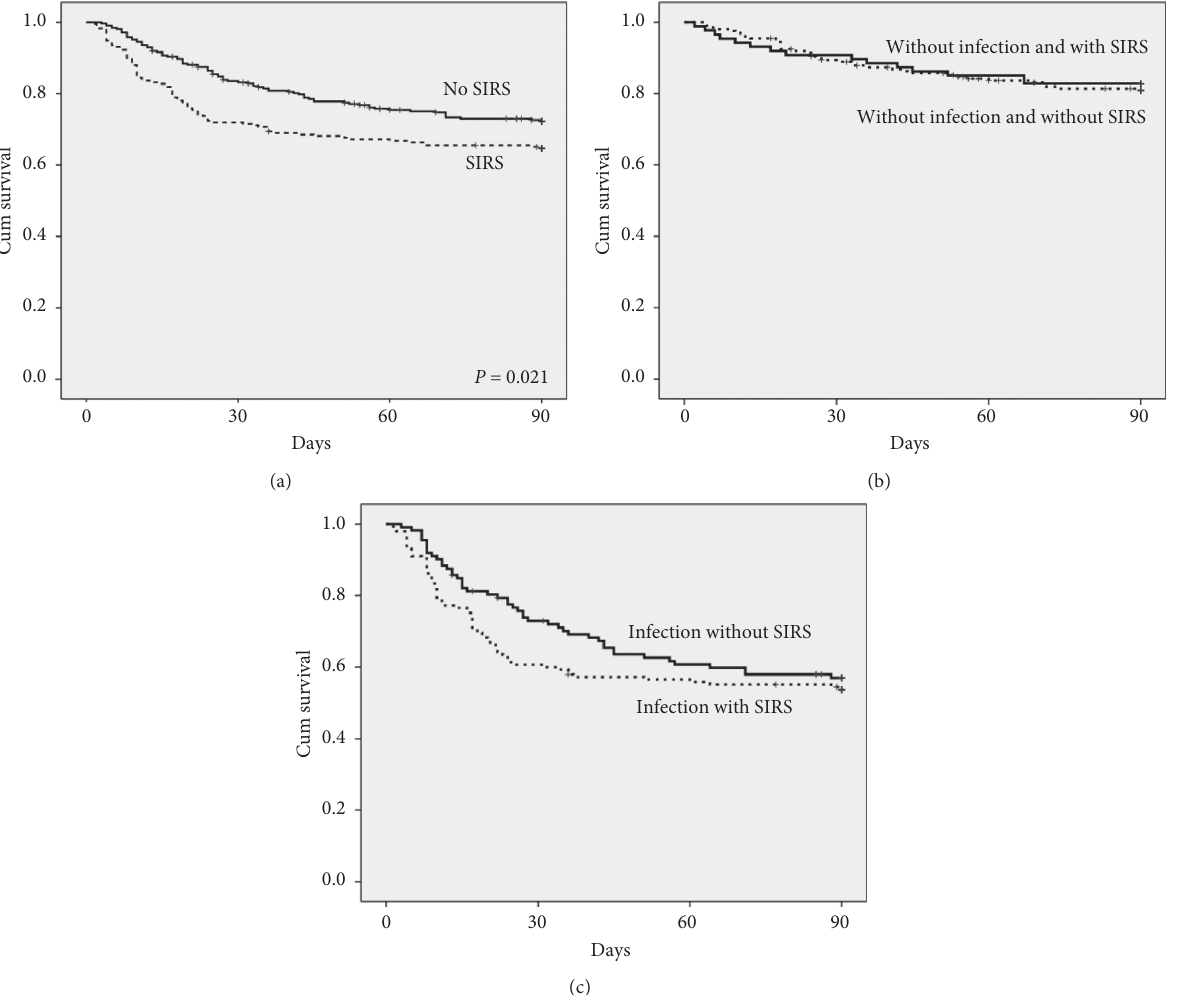
Figure 2: Cumulative 90-day survival of patients with cirrhosis according to the presence of SIRS. When considering the entire cohort, the 90-day survival probability was 73.0% for patients with SIRS and 64.7% for those without it (a). Among patients without infection, the 90- day Kaplan–Meier survival probability was 82.8% in subjects without SIRS and 81.4% in those with SIRS (b). SIRS criterion was also applied in patients with infection and the survival probability was 58.0% in subjects not fulfilling SIRS criterion and 53.8% among those who fulfill it